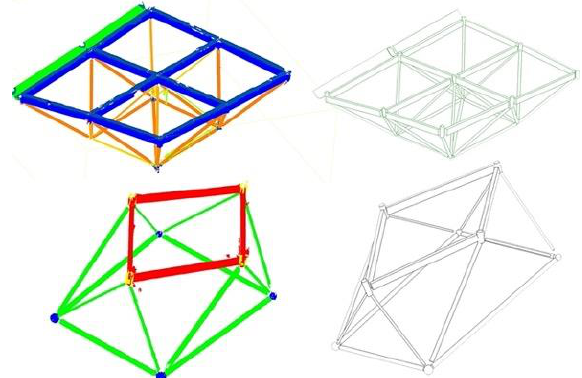
Figure 38. Classified point cloud and corresponding BIM model for the two selected mesh grids.